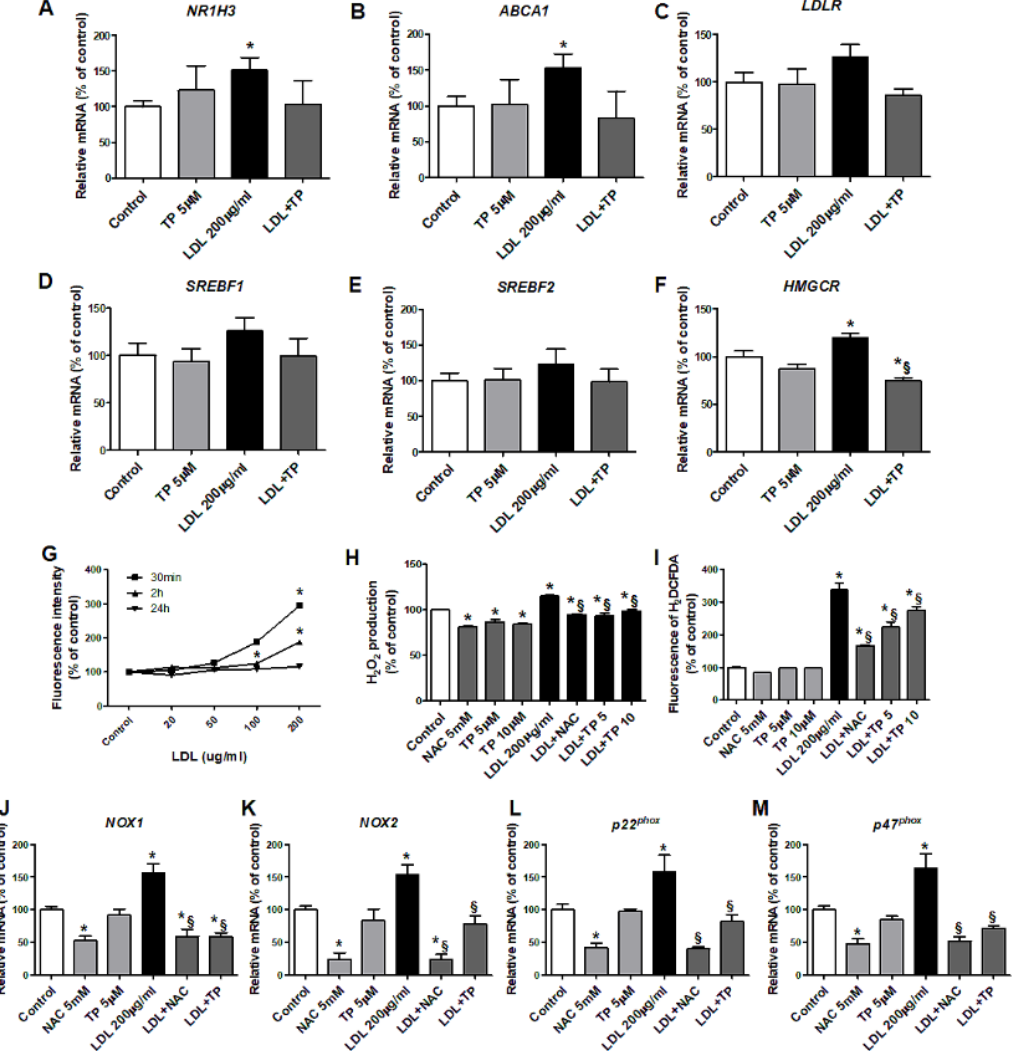
Figure 3. E ff ects of xanthine oxidase inhibitor on the expression of genes related to cholesterol